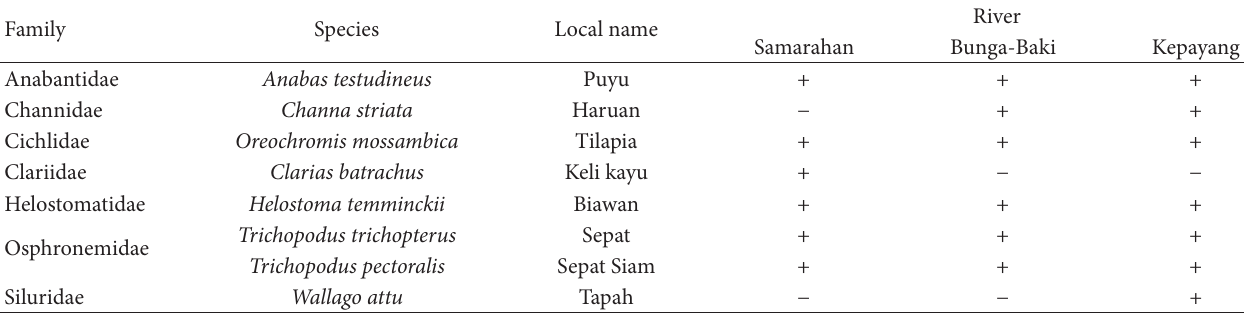
Table 5: Checklist of fish in Samarahan River, Bunga-Baki River, and Kepayang River.